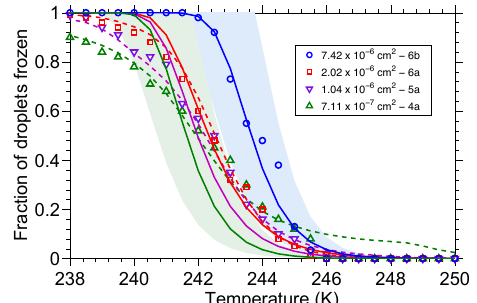
Figure 5. Experimental freezing curves for different surface area concentrations of illite mineral powder immersed in 10–20µm di- ameter water droplets taken from Broadley et al. (2012) (circles). Lines are modeled predictions of the same data using the g ∗ distri- bution method. Solid lines are produced directly from the global g distribution first obtained from the high concentration system. The dashed lines are obtained by randomly subsampling the global g distribution to obtain g ∗ and following a surface area correction, as described in the text. The shaded region shows the predicted tem- perature range over which freezing of droplets occurs for the sur- face area variability associated with the droplet diameter range of 10–20µm using g (i.e., running Eq. 9 with different values for A ) for the highest and lowest particle concentration